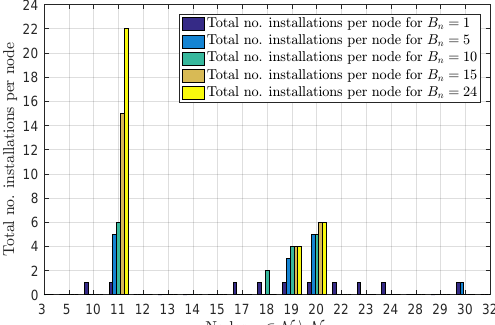
Figure 7. Total number of installations per